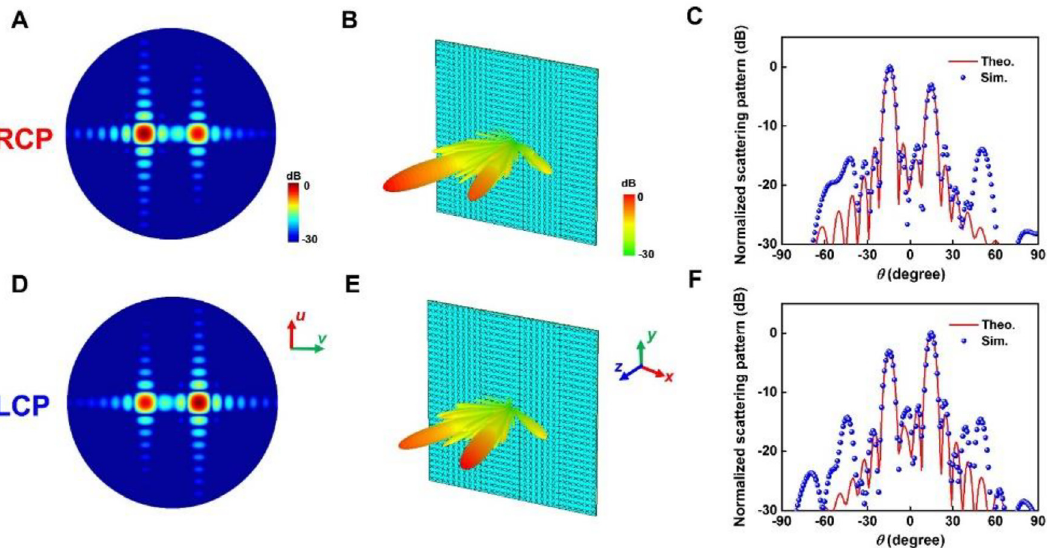
Figure 4: The 3D normalized scattering patterns for the (A) right-handed circularly polarized (RCP) and (D) left-handed circularly polarized (LCP) incidence at 8.6 GHz. The corresponding simulated 3D normalized scattering patterns for (B) RCP and (E) LCP incidence at 8.6 GHz. The corresponding simulated 2D normalized scattering pattern for (C) RCP and (F) LCP incidence in the xoz plane at 8.6